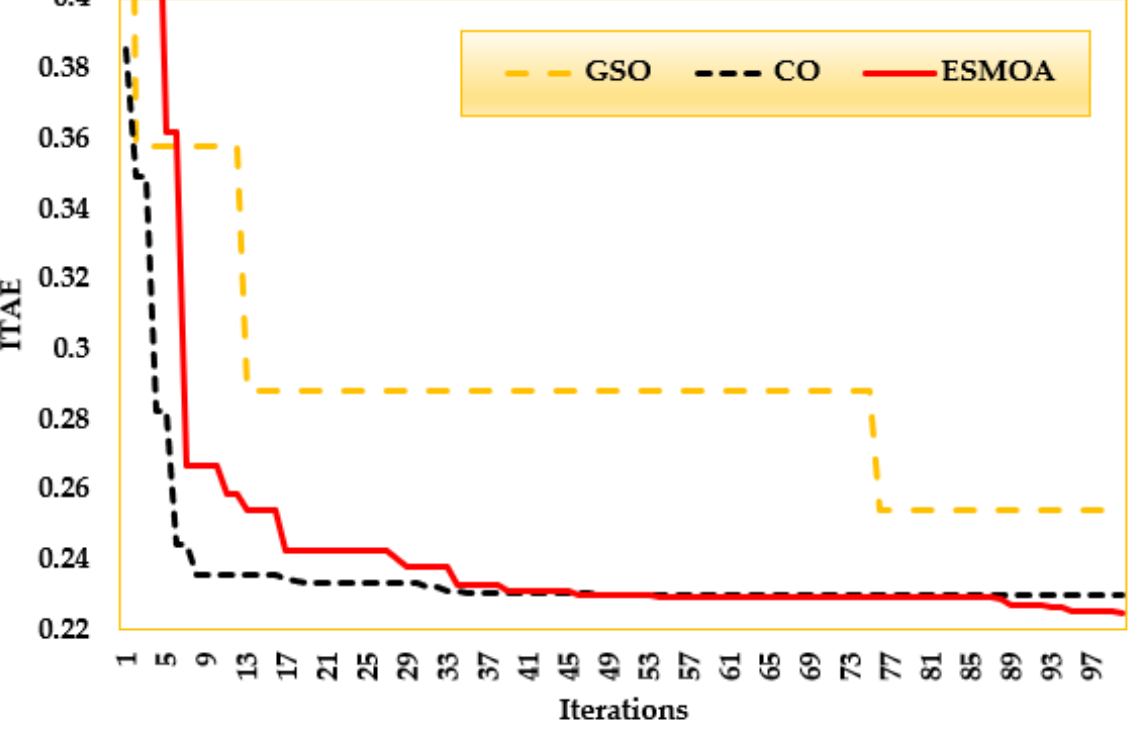
Table 9. Results for Case 4.